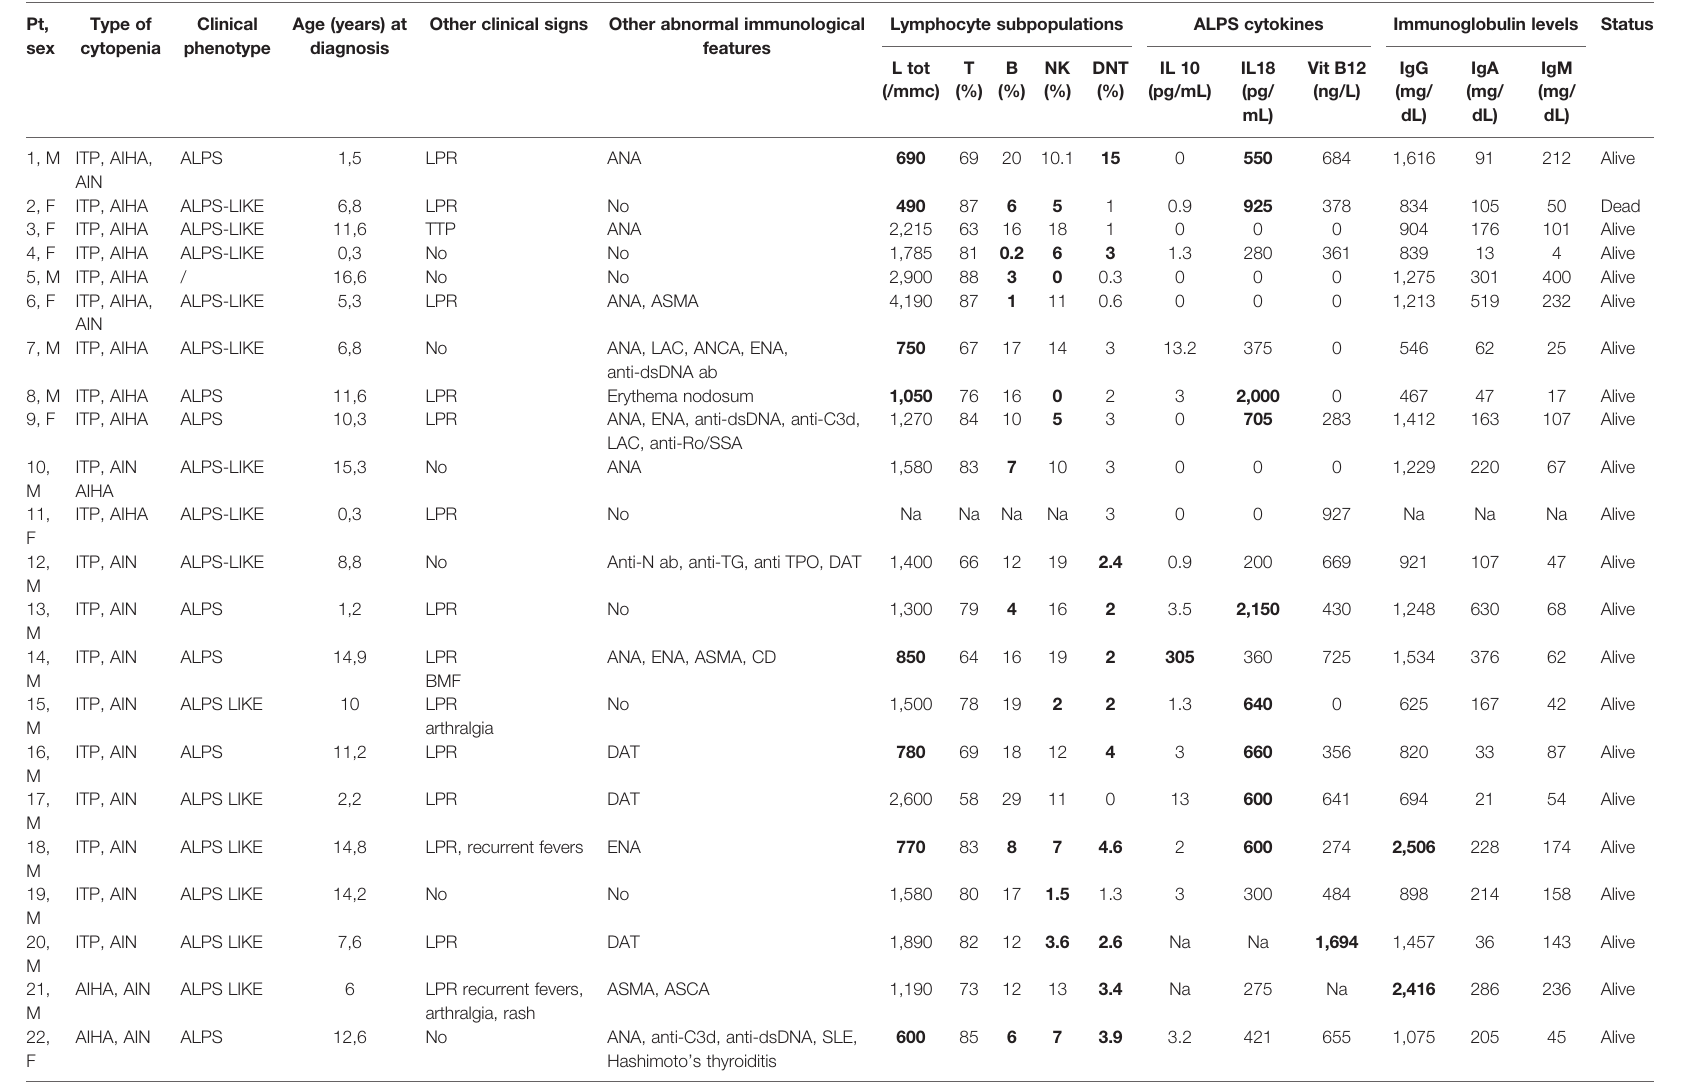
anti-dsDNA ab,anti-double-stranded DNAantibodies; anti-Nab,anti-neutrophil antibodies; AIHA, autoimmunehaemolytic anaemia; AIN, autoimmuneneutropenia; ANA, antinuclearantibodies; ANCA,anti-neutrophil cytoplasmicantibodies; ASCA,anti-Saccharomycescerevisiaeantibodies;ASMA,anti-smoothmuscleantibodies;B,benign;BMF,bonemarrowfailure;CD,celiacdisease;DAT,directantiglobulintest;DNT,double-negativeTcells;ENA,extractablenuclearantigen antibodies; ITP, immune thrombocytopenia; LAC, lupus anti-coagulant; LPR, lymphoproliferation (chronic, >6 months, non-malignant, non-infectious lymphadenopathy or splenomegaly or both); MAS, macrophage activation syndrome; Na, not available; SLE, systemic lupus erythematosus; Tg, thyroglobulin; TPO, thyroid peroxidase; TTP, thrombotic thrombocytopenic